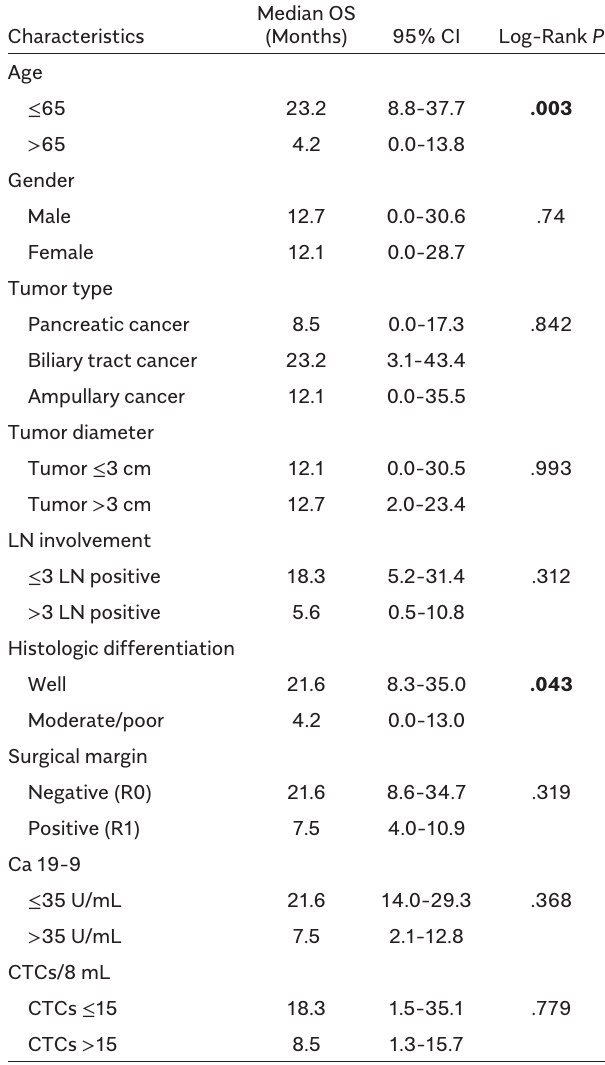
Table 4. Univariate Analysis for Overall Survival